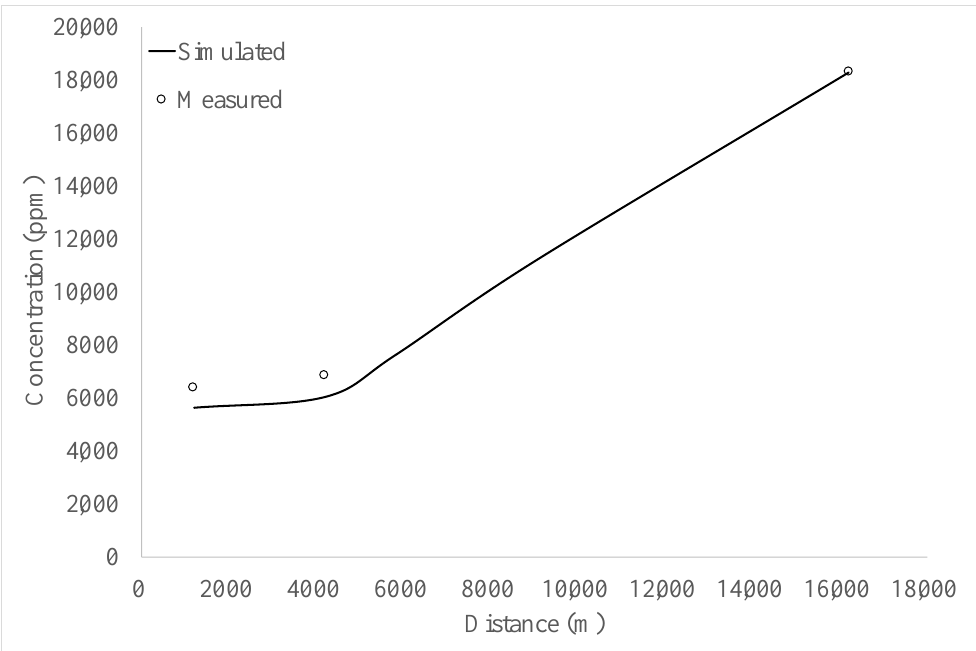
Figure 8. Comparison of peak concentration during Typhoon Soudelor.